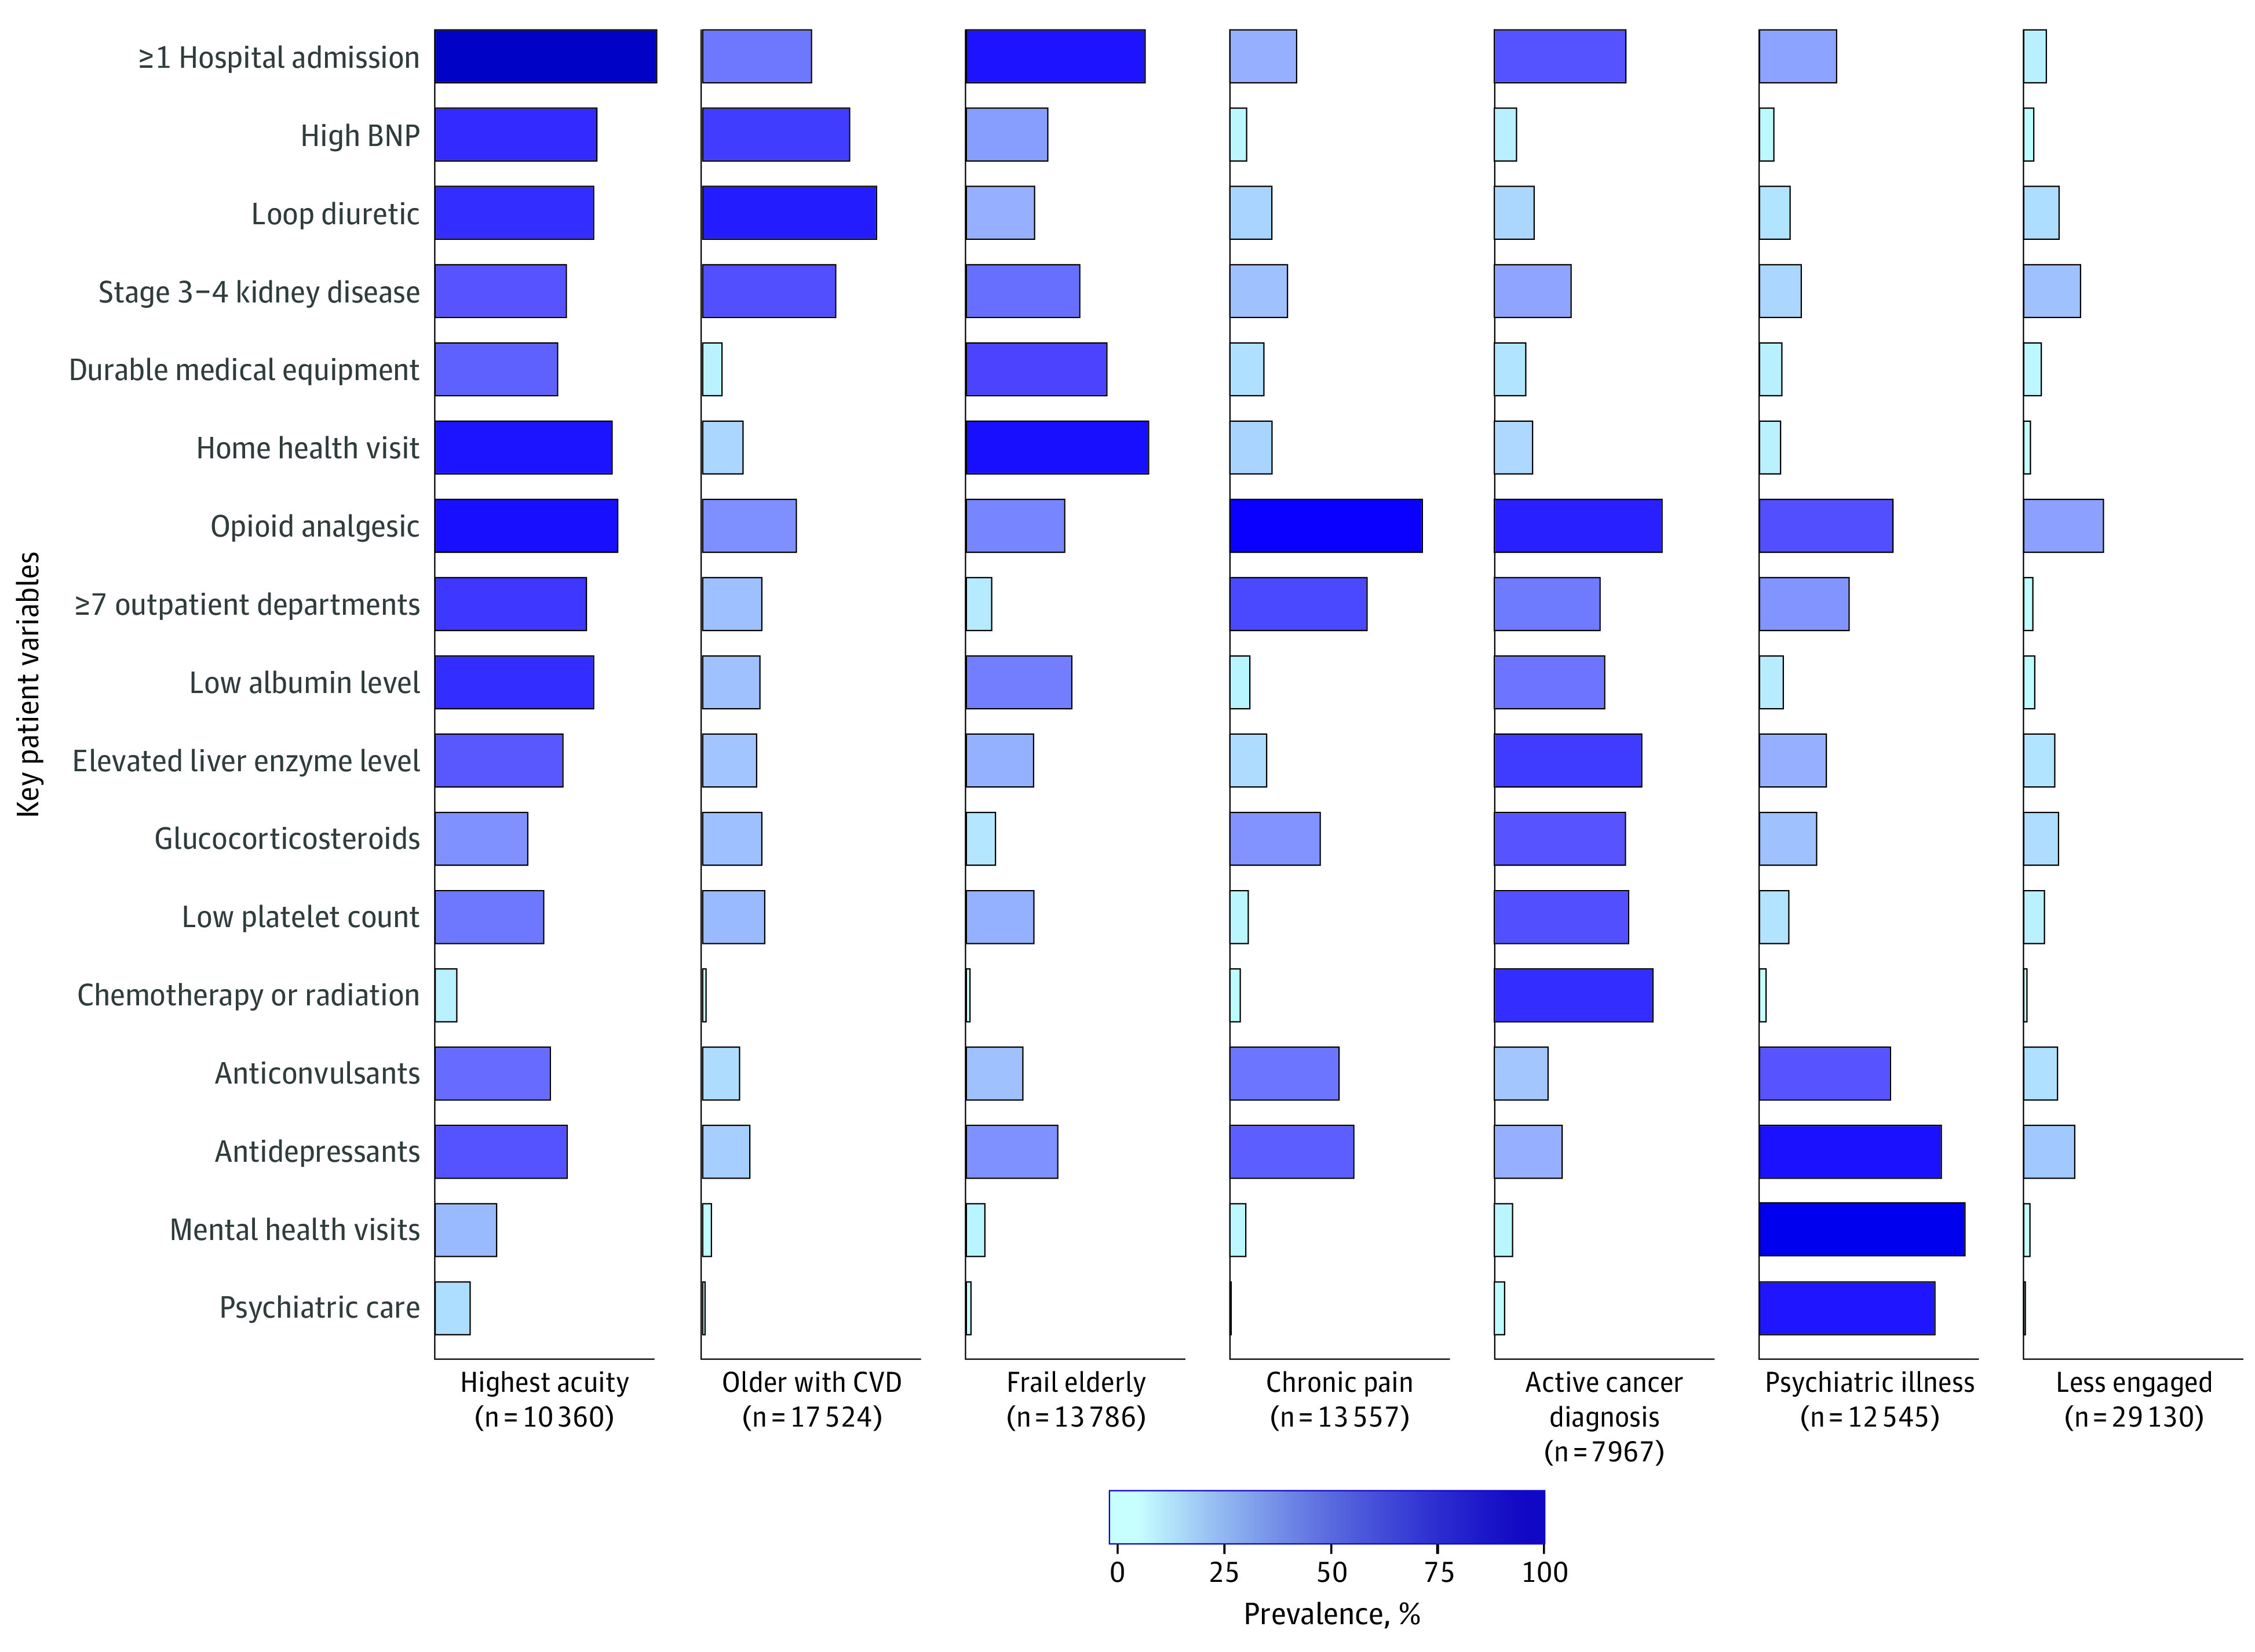
Seven Patient Profiles Derived From Latent Class AnalysisThe 17 variables were chosen from the 97 used in the latent class analysis model because they had the largest variation in prevalence across the 7 classes. Each listed variable had at least 55% prevalence in 1 or more class and less than 10% in other classes. BNP indicates brain natriuretic peptide; CVD, cardiovascular disease.